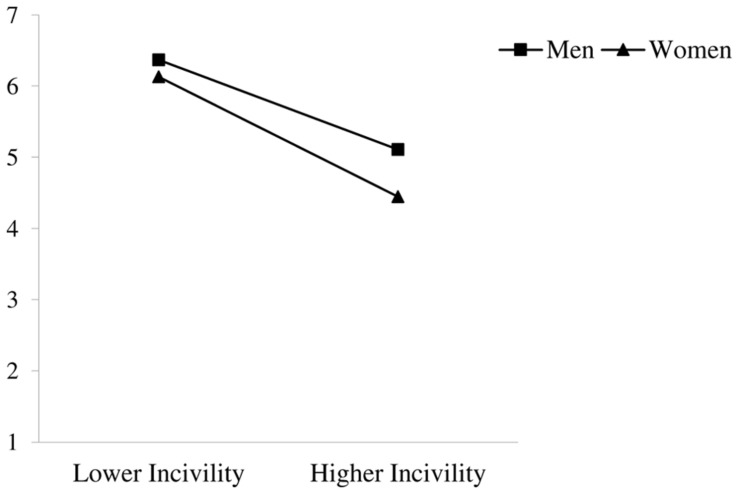
Interaction of workplace incivility and gender on job satisfaction.